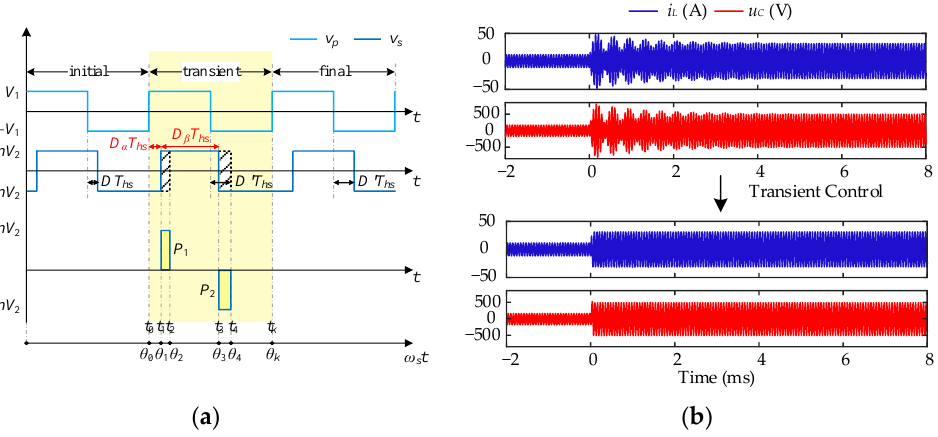
Figure 6. Transient control scheme for the resonant-type DAB proposed in [44]. ( a ) Control diagrams. ( b ) Simulation results.